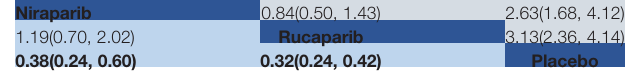
TABLE 4 | The network meta-analysis of PFS in BRCA-mutated patients. Olaparib